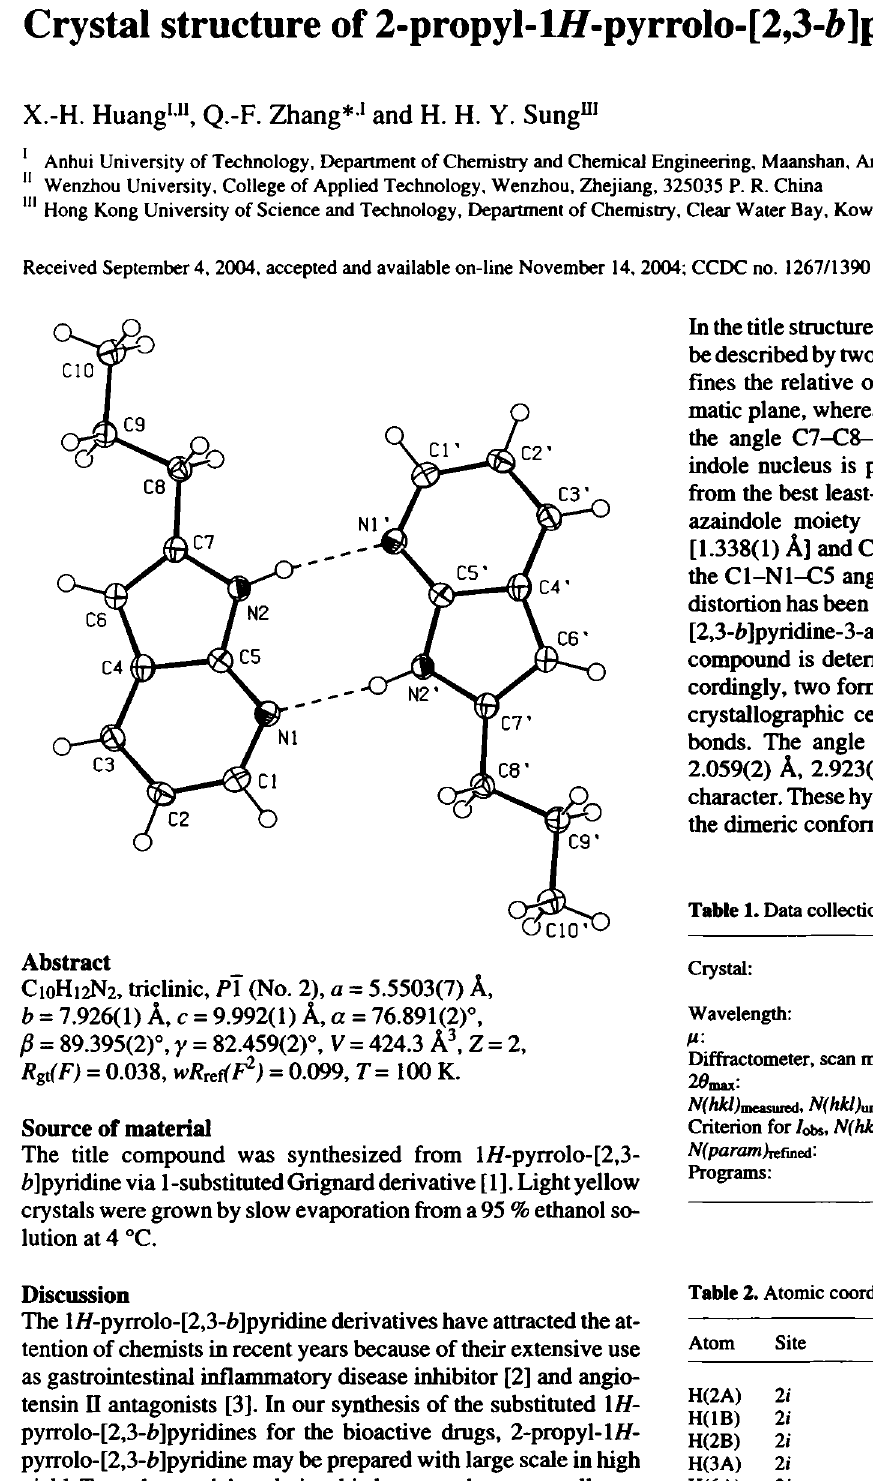
Table 2. Atomic coordinates and displacement parameters (in Â 2